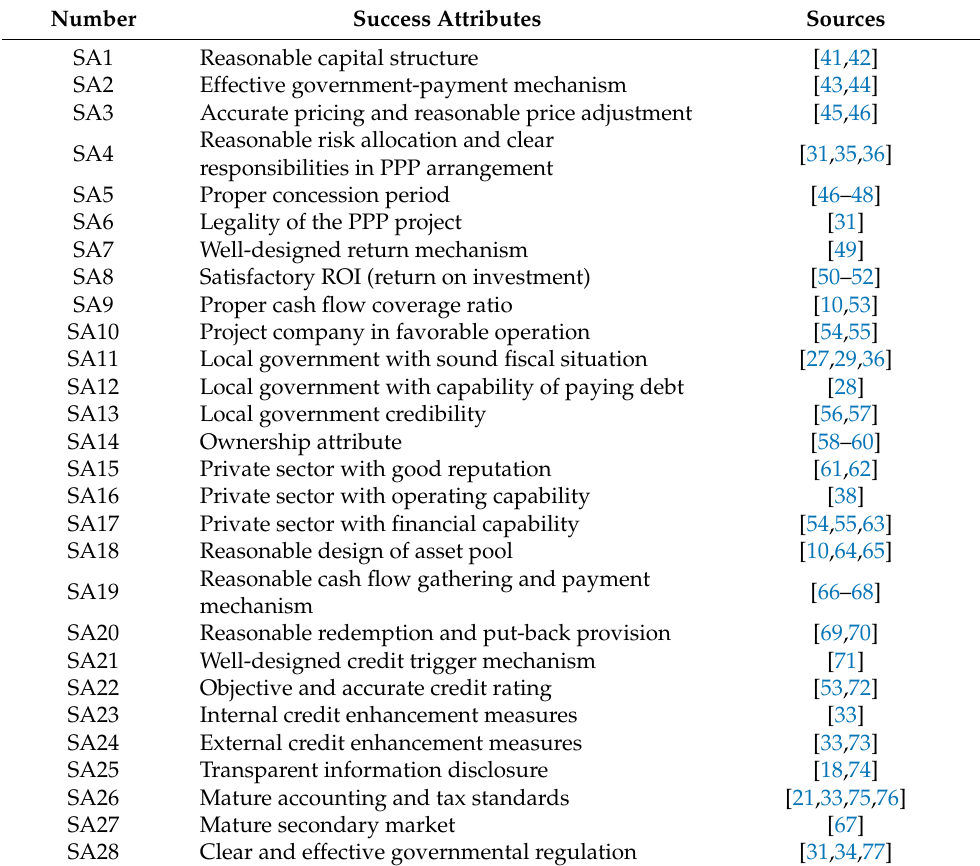
Table 1. Initial success attributes list of PPP–ABS (Source: Authors’